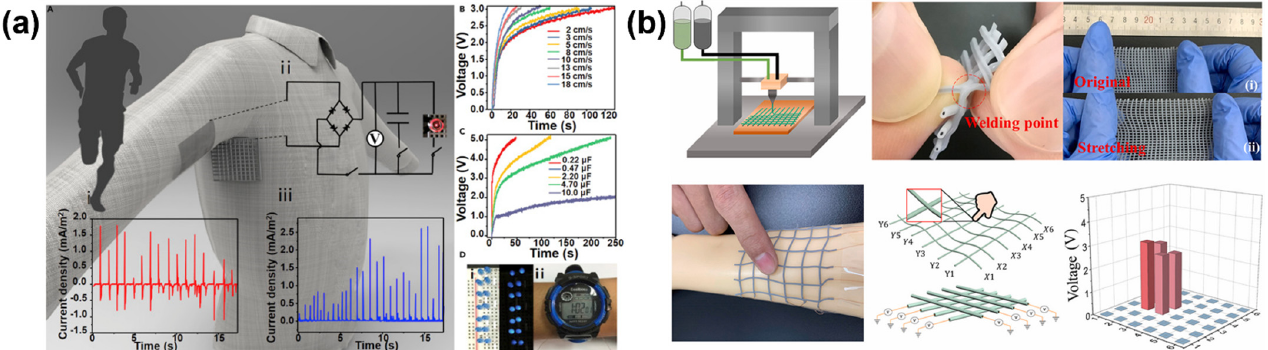
Figure 5. ( a ) The 3D printing of heat-adjusted textiles; ( b ) 3D printing of multifunctional, flexible phase-change nonwovens; ( c ) flexible grids which speed up finger recovery when clenching fists; ( d ) spaced hexagonal grids for fall-protective clothing [72–76].